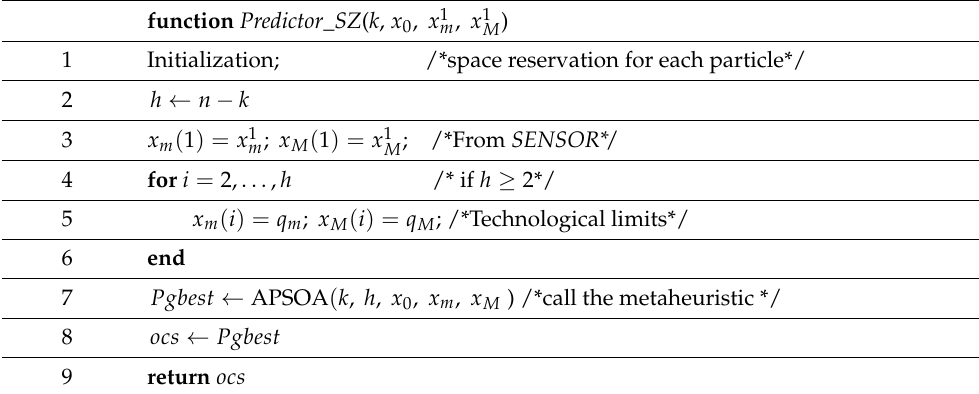
Table 3. Algorithm of the Predictor